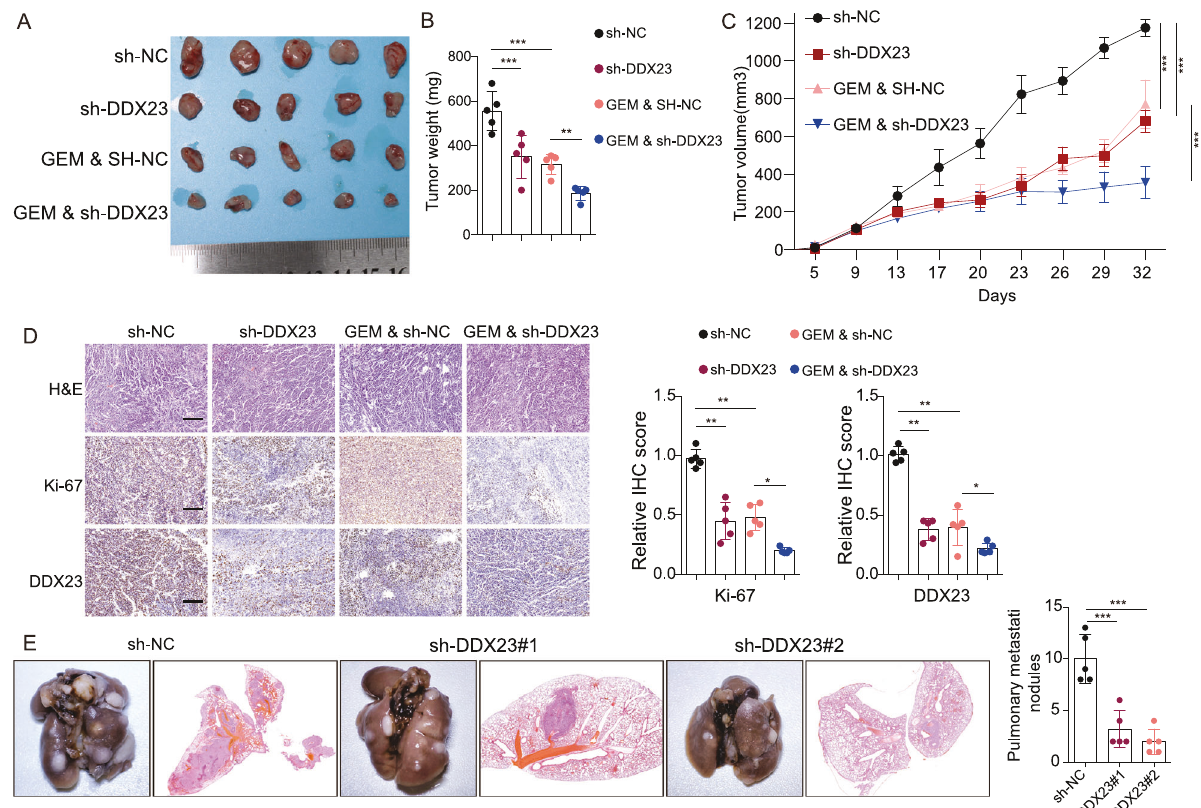
Fig. 6 DDX23 knockdown led to suppressed in vivo tumor growth and lung metastasis. A – C The size ( A ), weight ( B ), and volume ( C ) of the in vivo tumors showed that DDX23 knockdown led to suppressed tumor growth in synergy with gemcitabine treatment. D H&E and Ki-67